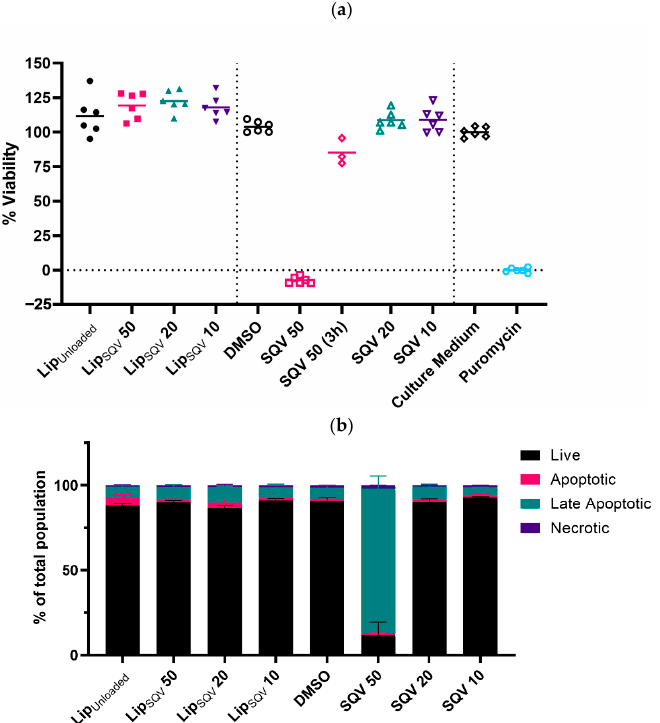
Figure 2. SQV-loaded liposomes present no cytotoxicity for human macrophages after 3 days of treatment. ( a ) Macrophages were treated with the selected concentrations of LipSQV or free SQV and incubated with the drugs for 3 days. Additionally, free SQV was tested at 50 μ g/mL for only 3 h. Macrophage viability was measured using PrestoBlue (resazurin-based solution) by quantifying the fluorescence emission in a plate reader. LipUnloaded or DMSO were used as the negative controls and puromycin (5 μ g/mL) as the positive control for cell death. The symbols depict the relative viability of cells from different donors compared to cells treated with culture medium alone. ( b ) Cell death was measured by flow cytometry analysis of Mtb-infected macrophages following 3 days of treatment, using Apotracker Green and Zombie Red viability dyes. Bars represent the average of two independent experiments and the error bars depict the standard error of the mean.